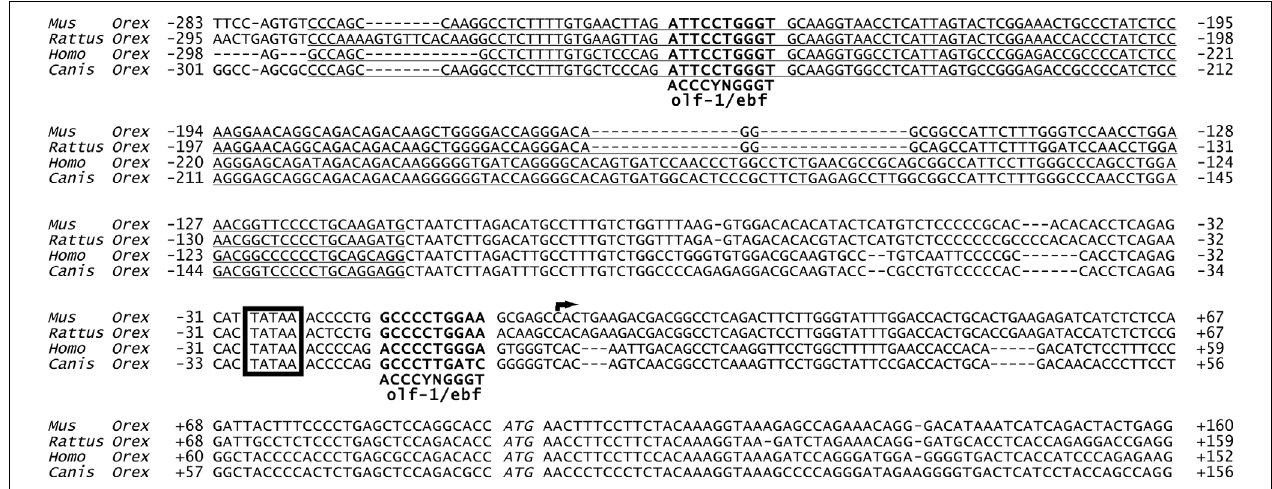
olfactory epithelium. One of these olf-1-like elements overlaps with one of the regions (OE1, underlined) that appear to restrict prepro-orexin expression in the lateral hypothalamus.The second olf-1-like element lies at position-7 from the putative transcription start site (arrow indicating direction of transcription). A conservedTATA box can also be identified at position-24 in all these genes. Translation start site (ATG) is indicated in italics.